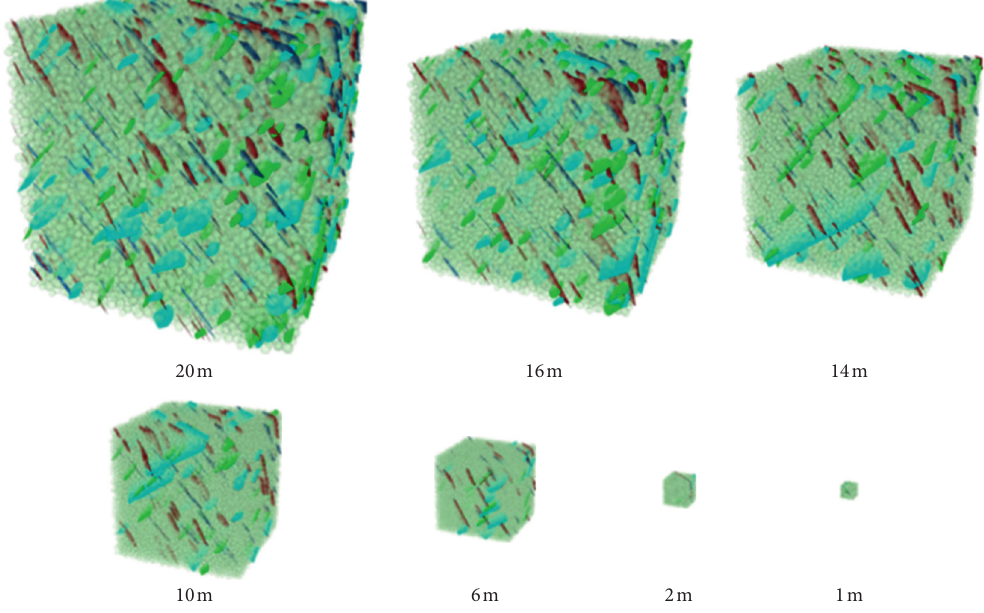
Figure 12: Multiscale SRM